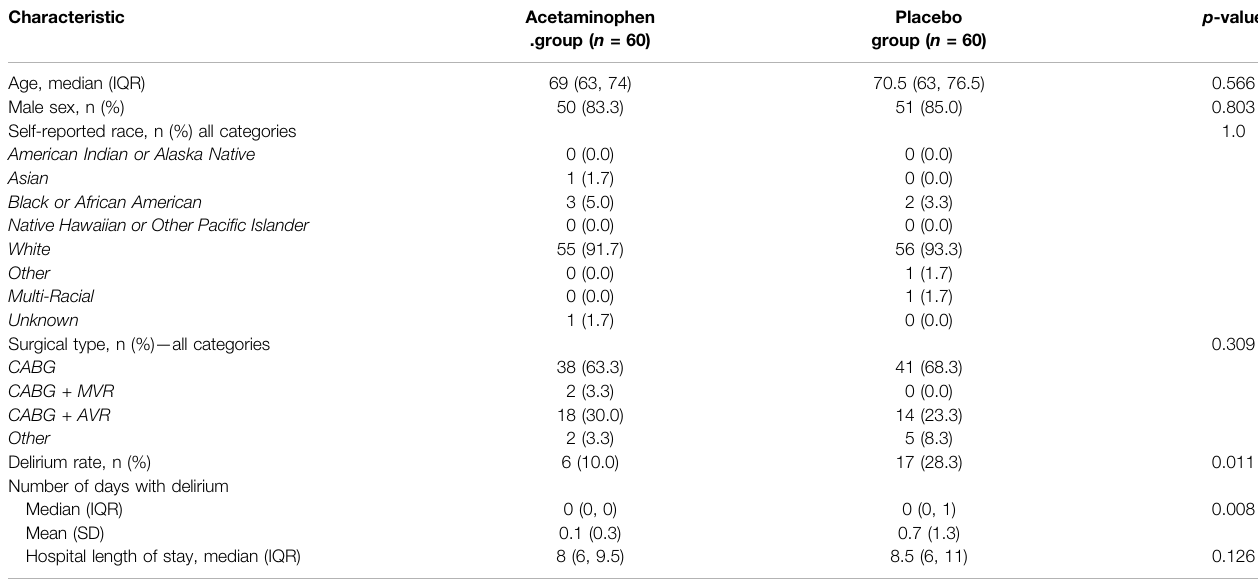
TABLE1| Patientcharacteristicsbytreatmentgroup.Patientcharacteristicsarecomparedbetweentreatmentgroupsandnosigni fi cantdifferencesarefound.Outcomesof deliriumrateandmedianhospitallengthofstayarealsocompared,andasigni fi cantdifferenceisfoundindeliriumratewith10%intheacetaminophengroupand28.3% in the placebo. Wilcoxon Rank-Sum tests and chi-square or fi sher exact tests were utilized to compare the characteristics of the groups. ( IQR: Interquartile range, CABG: Coronary artery bypass grafting, AVR: Aortic valve replacement, MVR: Mitrial valve replacement )